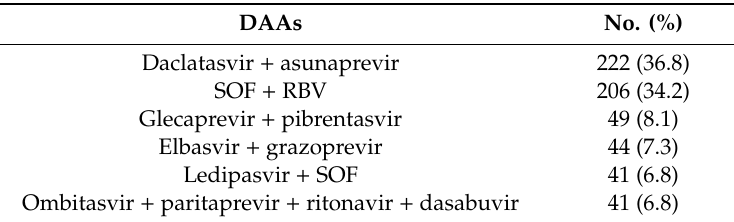
Table 2. Types of DAAs (n =